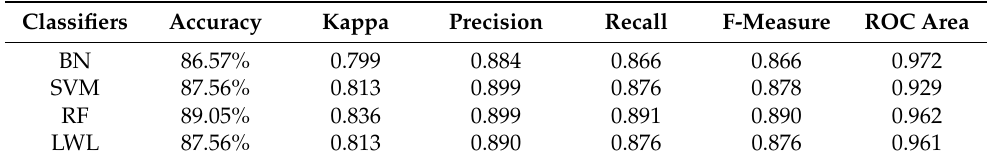
Table 7. Multiclass classification of